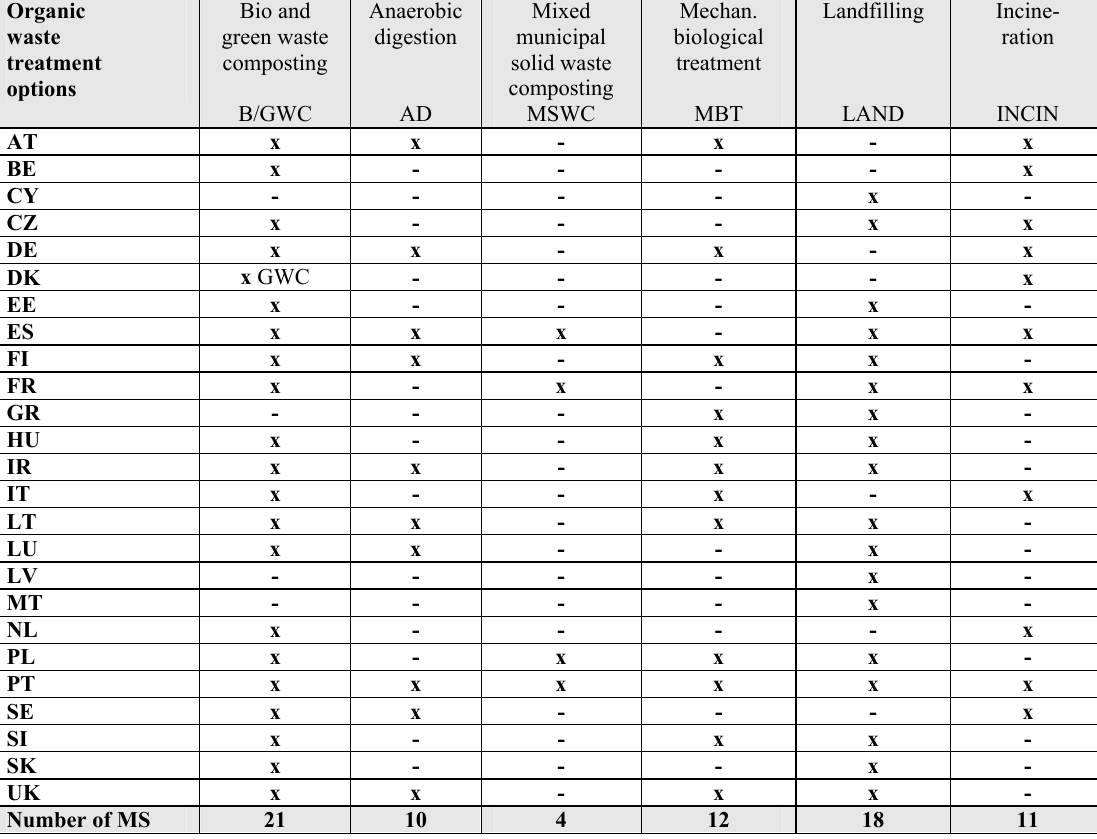
Table 44: Common organic waste treatment options in the EU Member States Organic waste